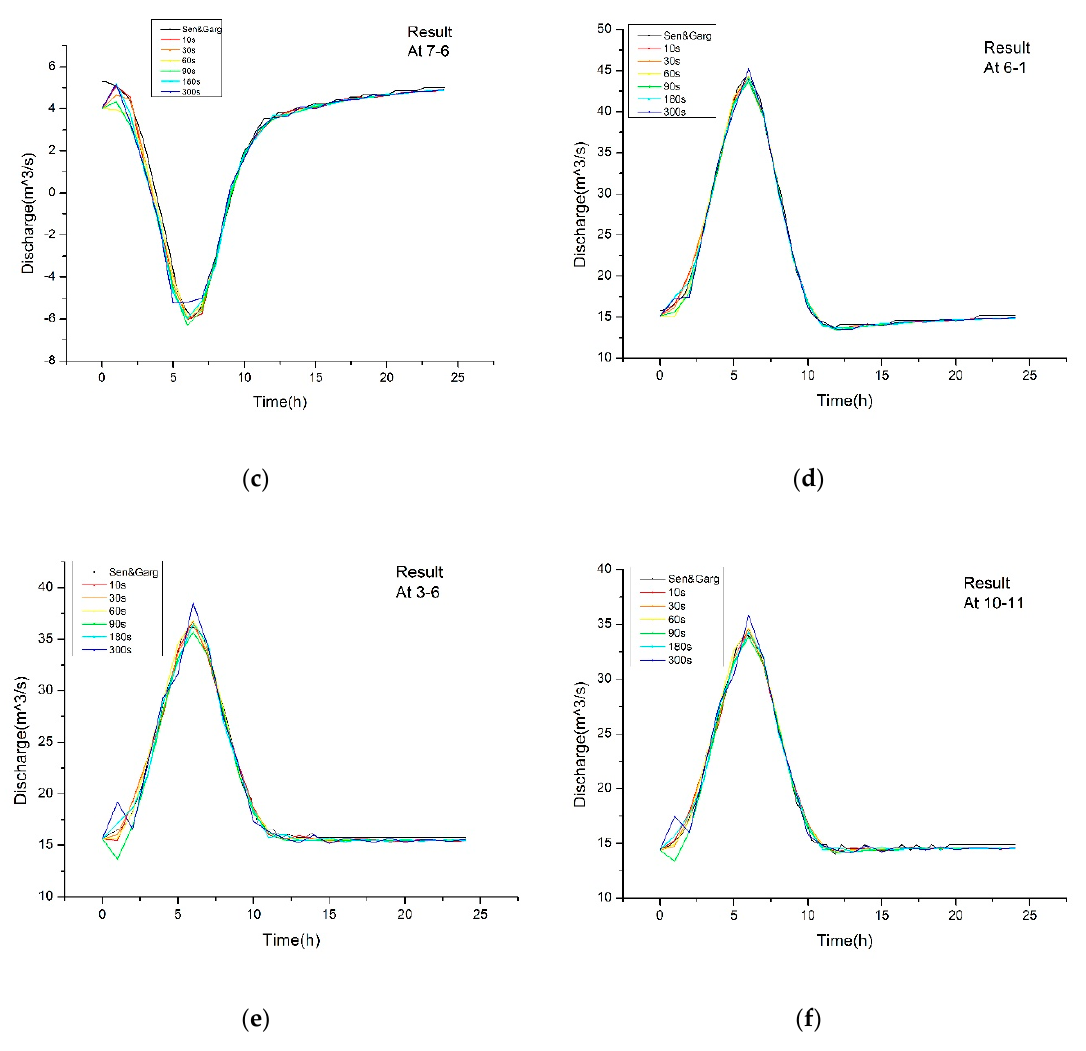
Figure 3. Boundary condition and results of loop network 1: ( a ) inflow discharge at 8 − 1, ( b ) discharge at 1 − 1, ( c ) discharge at 7 − 6, ( d ) discharge at 6 − 1, ( e ) discharge at 3 − 6, and ( f ) discharge at 10 − 11.